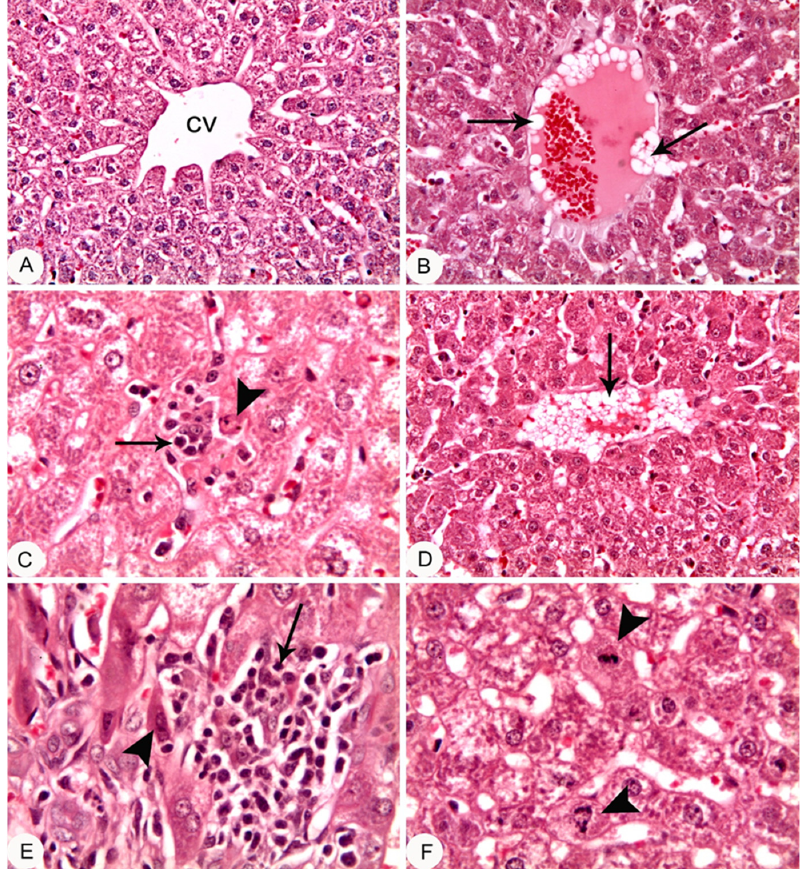
Figure 2. Liver, Rabbit. ( A ) control group: showing normal histological architectures. CV, central veins. ( B , C ) 100 mg Ficus sycomorus extract-treated group: ( B ) shows the aggregation of fat globules in the bloodstream of the central vein (arrows). ( C ) shows coagulative necrosis of some hepatocytes (arrowhead) and proliferation of Kupffer cells (arrow). ( D – F ) 200 mg Ficus sycomorus extract-treated group: ( D ) shows the extensive aggregation of fat globules in the bloodstream of the central vein (ar- row). ( E ) shows marked coagulative necrosis of hepatocytes (arrowhead) and extensive proliferation of Kupffer cells (arrow). ( E ) shows mitosis of hepatocytes (arrowheads) that indicate compensatory regeneration. HE stain, ( A , B , D ) × 20; ( C , E , F ) ×